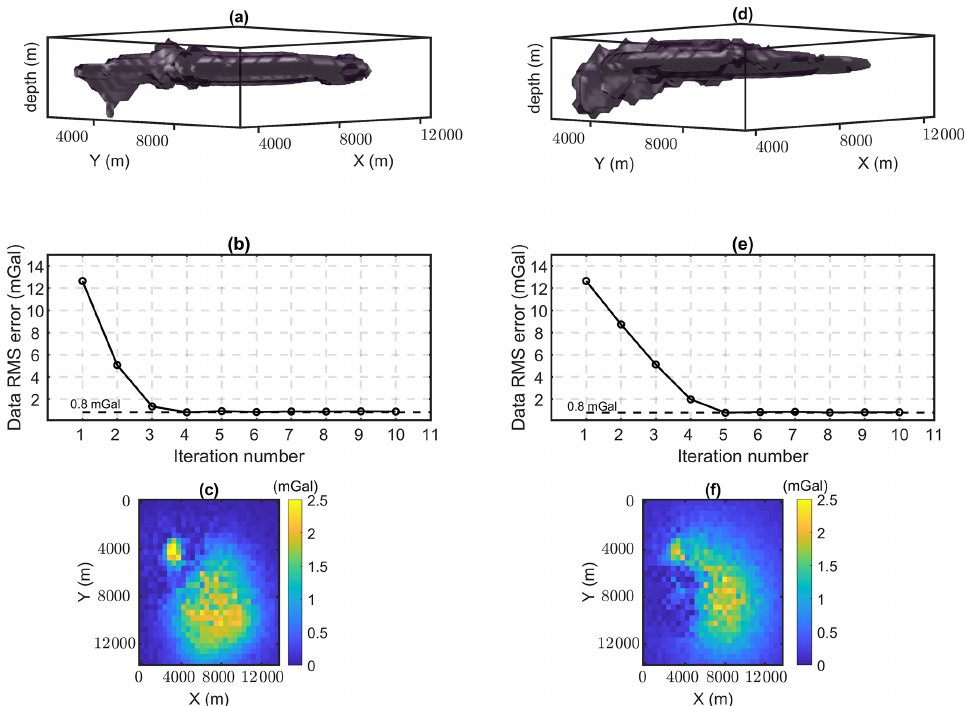
Figure 3. The 3D views of the inverted model from the constrained (a) and unconstrained inversion (d) . Corresponding evolution of data root-mean-square errors (RMSEs) (b, e) , and (c) the corresponding final calculated difference between the field and calculated gravity datasets (c, f)